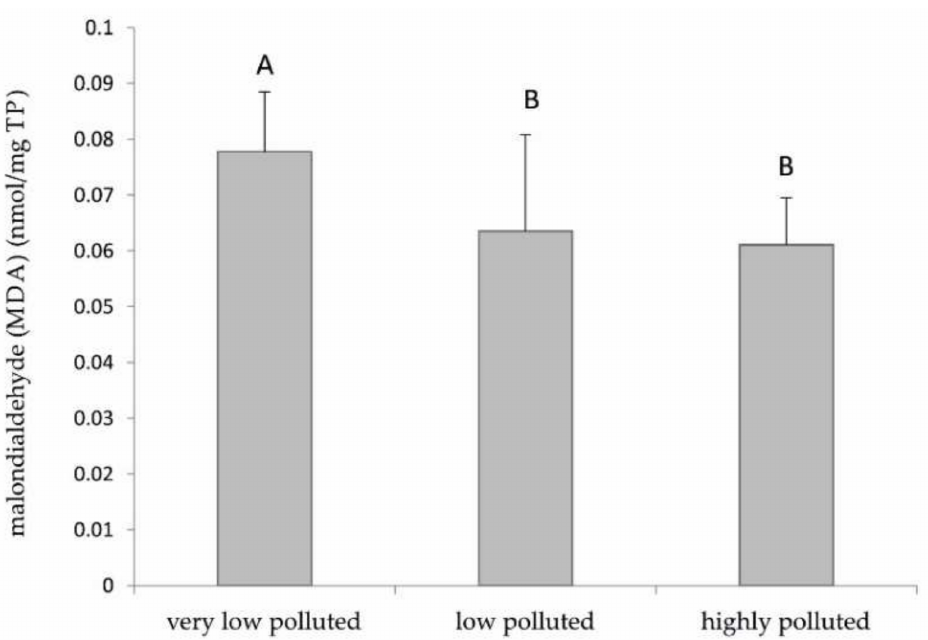
Figure 2. Malondialdehyde mean concentrations in S. cephalus liver. Values (arbitrary units) are indi- cated as mean ± SD. Different letters correspond to significant statistical differences ( p < 0.05) among different sites (Student–Newman–Keuls test). Eight specimens per site were singularly